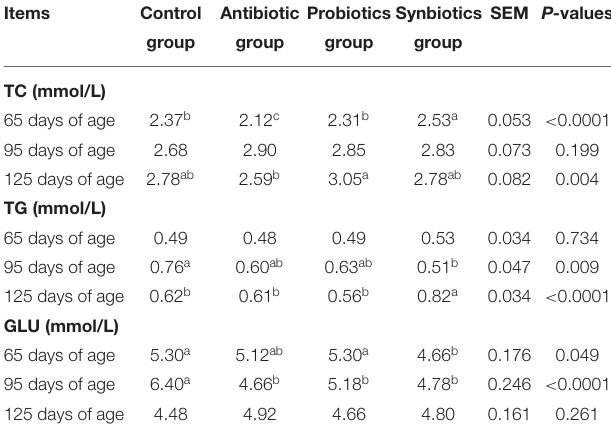
TABLE 6 | Effects of probiotics and synbiotics addition in sows’ diets on plasma biochemical parameters of offspring